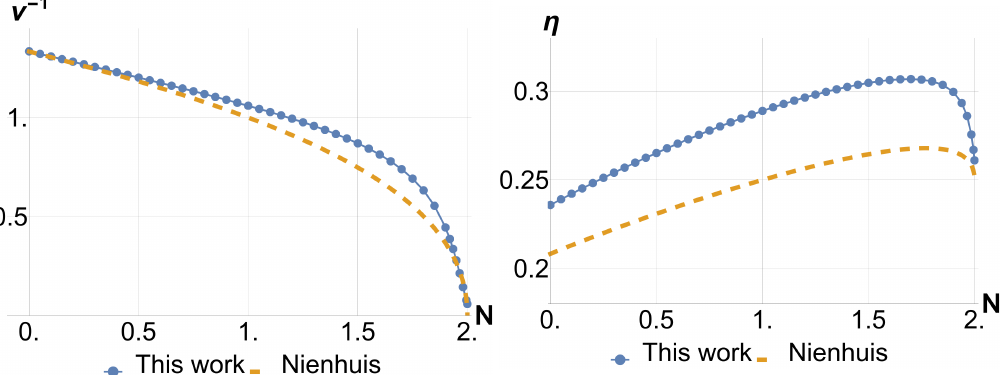
Figure 5: The critical exponents ν − 1 and η as functions of N for d = 2. The singular first derivatives at N = 2 are clearly